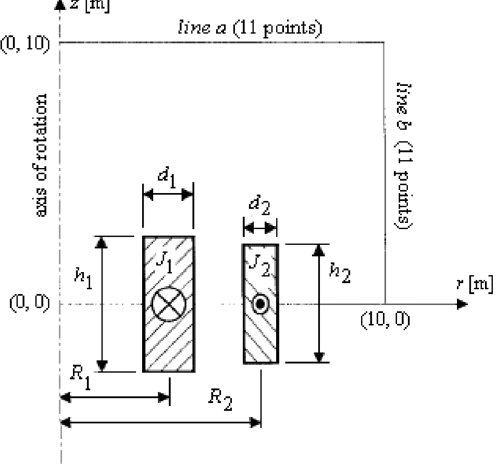
Figure 13. SMES device [25].